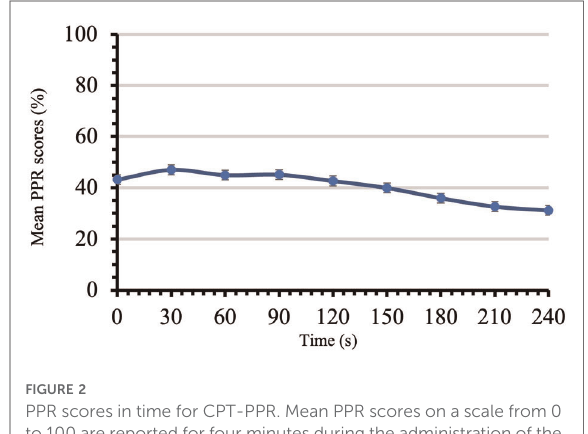
FIGURE 2 PPR scores in time for CPT-PPR. Mean PPR scores on a scale from 0 to 100 are reported for four minutes during the administration of the conditioning stimulus for PPR. Each time point shows mean±SEM.